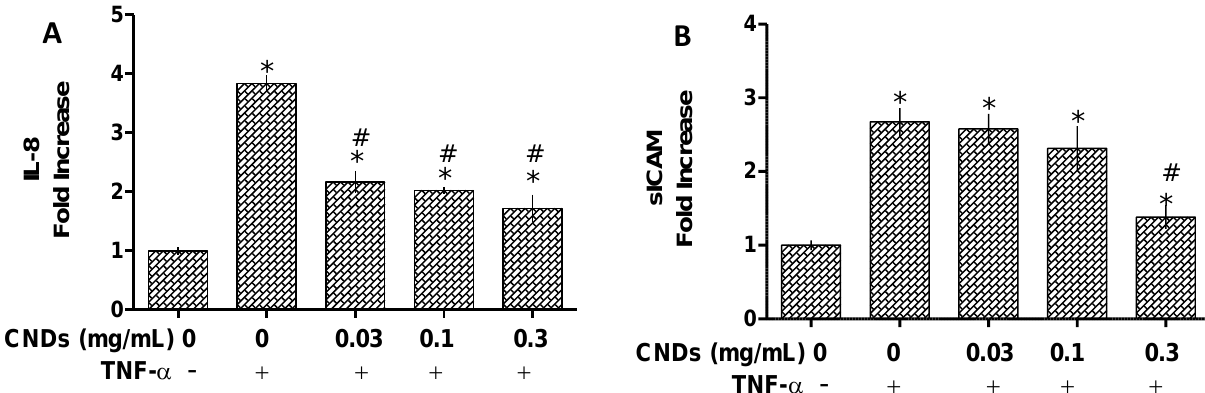
Figure 4. ELISA assay for IL-8 and ICAM protein quantification. HMEC-1 cells underwent treatment with 10 ng/mL of TNF-α as indicated with the presence or absence of 0.03, 0.1, or 0.3 mg/mL of CNDs for 6 h. After treatment, IL-8 ( A ) and soluble form of ICAM-1 (sICAM-1) ( B ) in the cell culture supernatants were measured by ELISA. All data represent mean ± SEM. (n = 3, * p < 0.05 vs. control; # p < 0.05 vs. TNF-α).